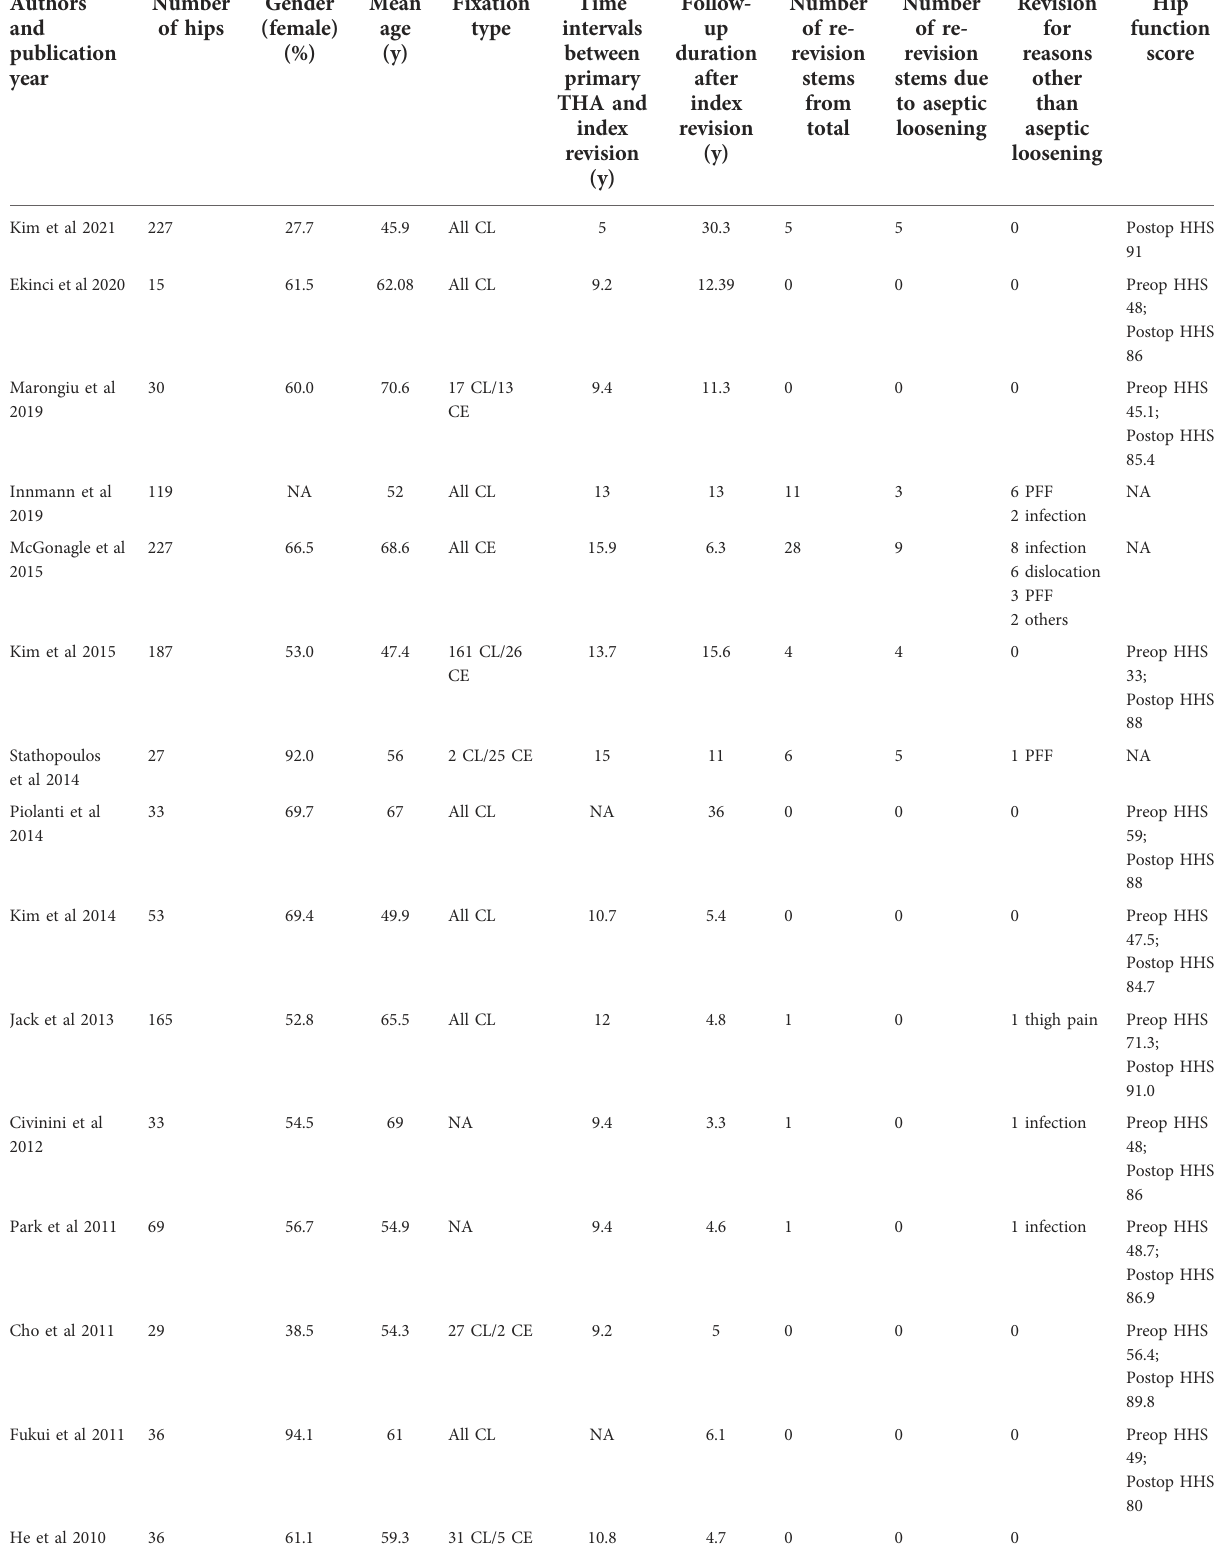
TABLE 1 Characteristics of the included